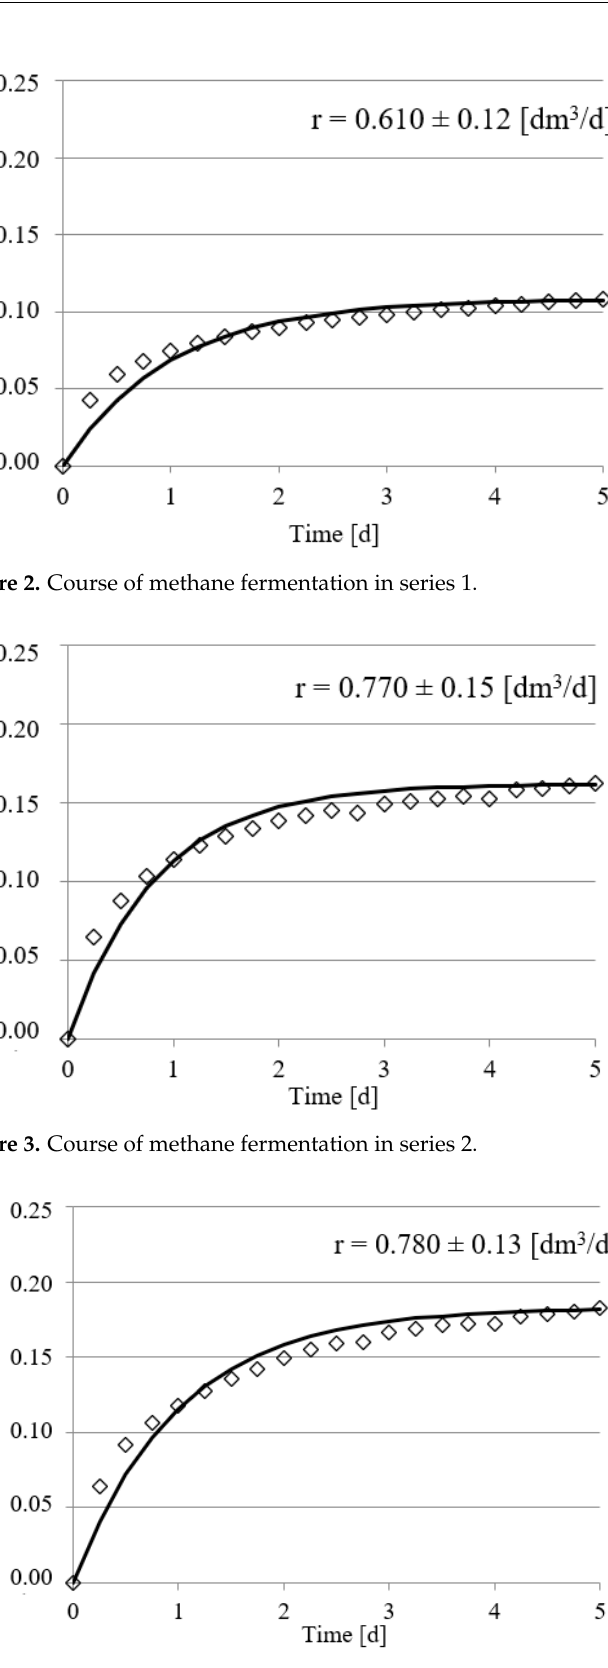
Figure 4. Course of methane fermentation in series 3.